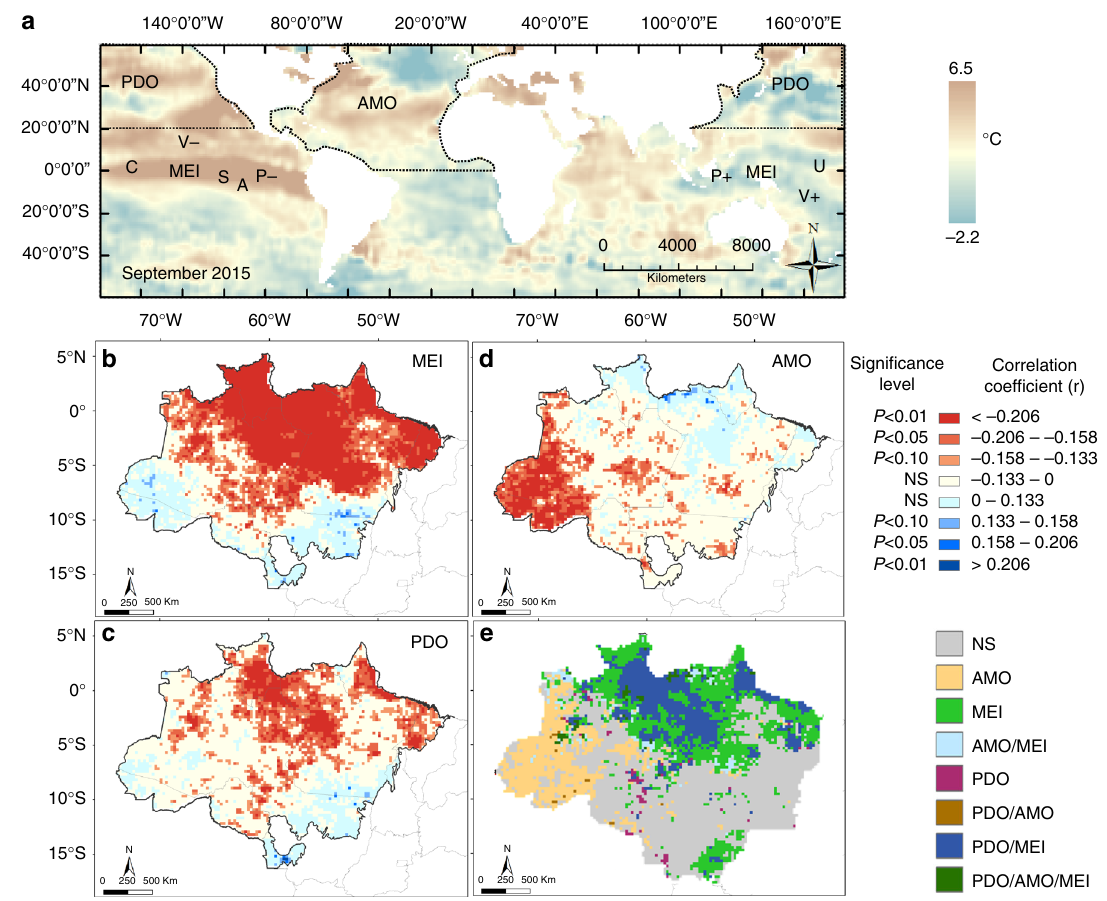
Fig. 2 Spatial location of oceanic modes and their in fl uence on the spatial distribution of rainfall reduction. a Sea surface temperature anomaly (SSTA) based on September 2015 monthly Reyn_SmithOIv2 global product (methods). Values are in degrees Celsius (°C). The fi gure display the regions used for calculation of the AMO 25 and PDO 27 indices as well as the approximate locations of the variables used for calculation of the MEI 26,44 . P+ and P − represent sea-level pressure dipole, U corresponds to the zonal westerly wind anomalies in central Paci fi c ocean, V+ and V − correspond to the southerly and northerly meridional wind anomalies, S is the sea surface temperature and A the surface air temperature, and C indicates cloudiness anomalies. Pixel-based monthly correlations between the oceanic indices and rainfall anomalies were calculated for b MEI, c PDO and d AMO. Classes in the map with red colour shades indicate that the increased value of one oceanic index has the effect of reducing rainfall in the speci fi c grid cell (negative correlation). Blue colour shades indicate the opposite. e Mapped grid cells with signi fi cant negative correlation coef fi cients ( p < 0.05) between oceanic indices such as the MEI ( b ), PDO ( c ) and AMO ( d ) and monthly rainfall anomalies. Classes in the map indicate where the increased value of one oceanic index or their combination has the effect of reducing rainfall in the speci fi c grid cell. All grid cells have a 0.25° spatial